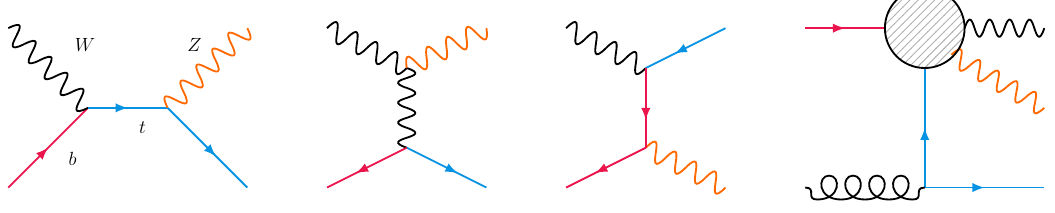
Figure 5 . SM diagrams for the b W → t Z sub-process. The far right diagram shows the embedding of the b W → t Z sub-amplitude, represented by the blob, into gb → tWZ production at a hadron